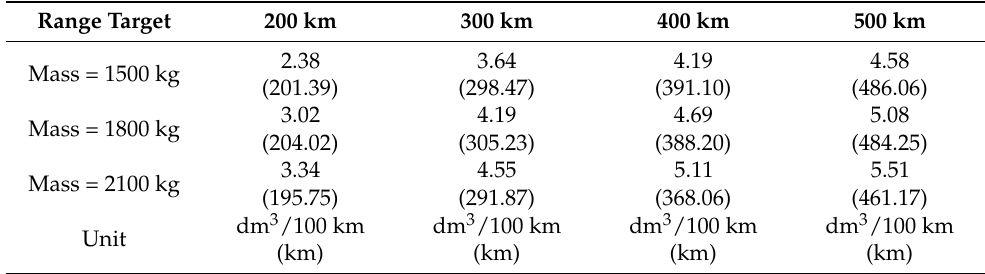
Table 16. Fuel consumption in EREV mode for WLTC 3b.